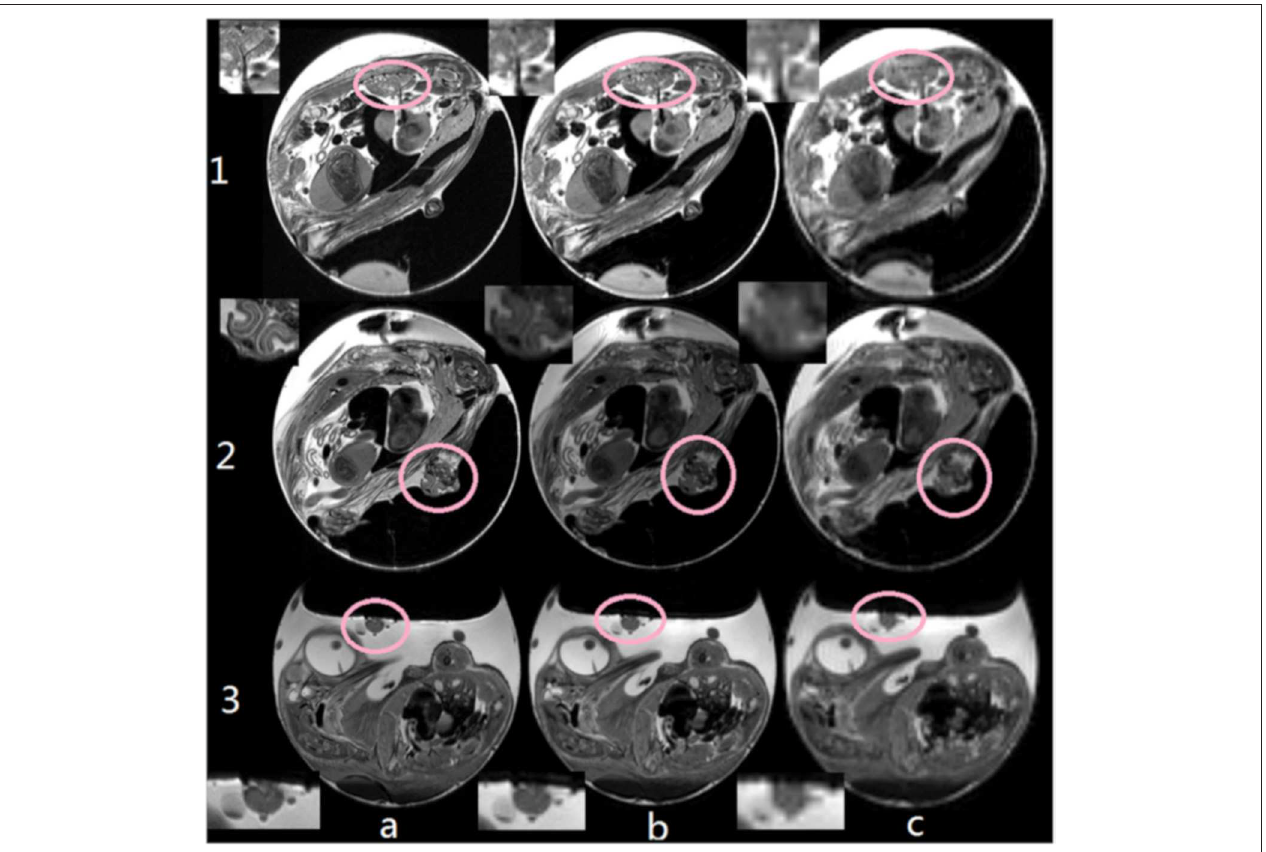
FIGURE 5 | Comparison between different image resolution: (a) 77 × 91 µ m 2 , (b) 200 × 200 µ m 2 , and (c) 500 × 500. With increasing resolution, details of e.g., the pulmonary veins (1), the beak (2, axial orientation), and tumor tissues (3) could be clearly resolved. Insets show details of the respective target structures. This research was originally published in NMR Biomed: High-resolution MRI analysis of breast cancer xenograft on the chick chorioallantoic membrane. Zuo et al. [